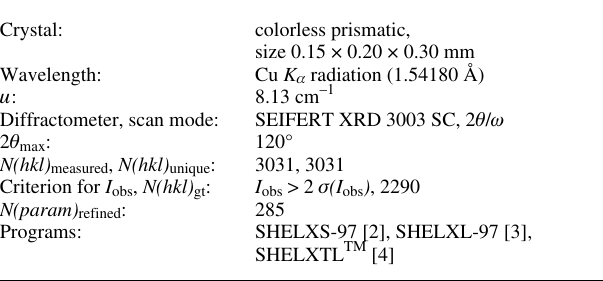
Table 1. Data collection and handling.